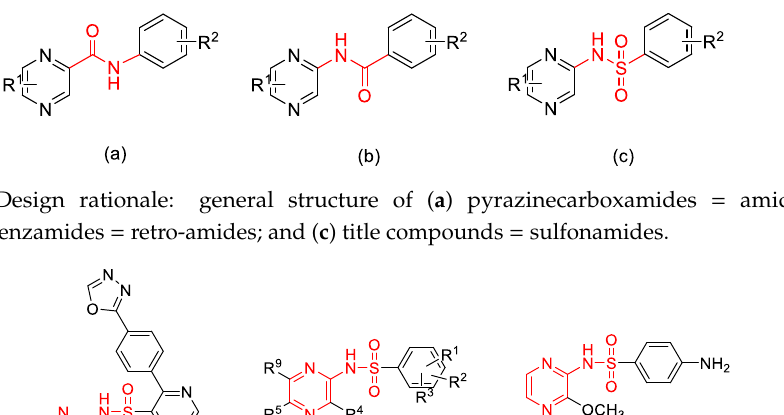
Figure 2. The chemical structure of ( a ) zibotentan, ( b ) halogenated N -(pyrazinyl)benzensulfonamides, and ( c ) sulfamethoxypyrazine (sulfalene).